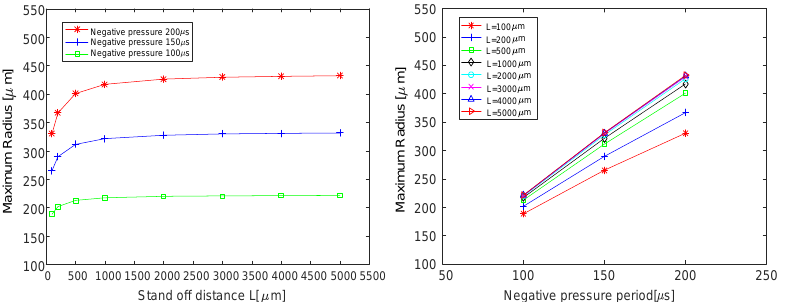
Figure 6. Relation between negative pressure and standoff distance on maximum bubble radius at constant initial radius 30 µ m.